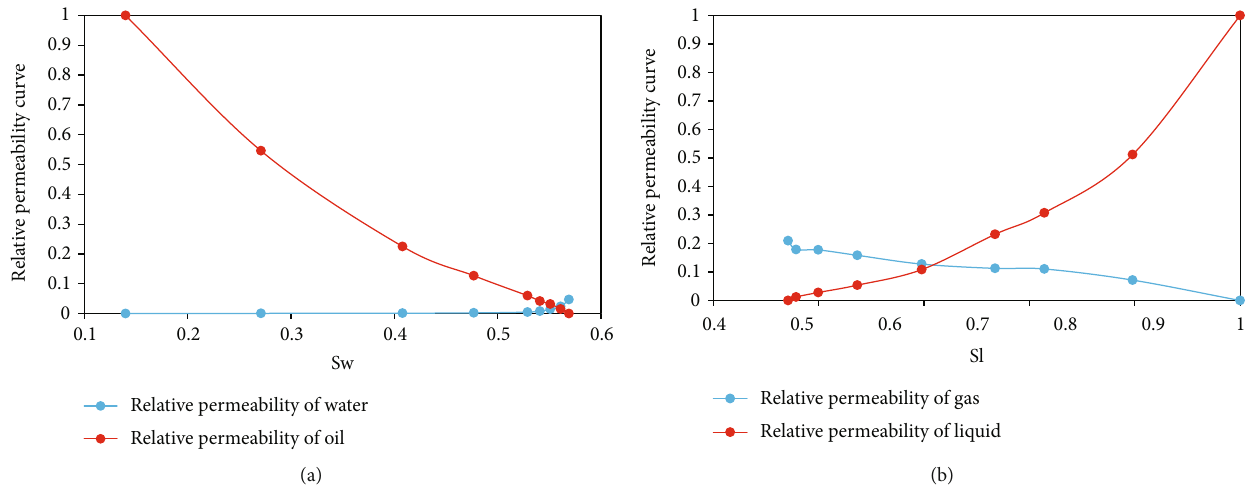
Figure 3: The relative permeabilities: (a) the oil-water relative permeabilities; (b) the gas-liquid relative